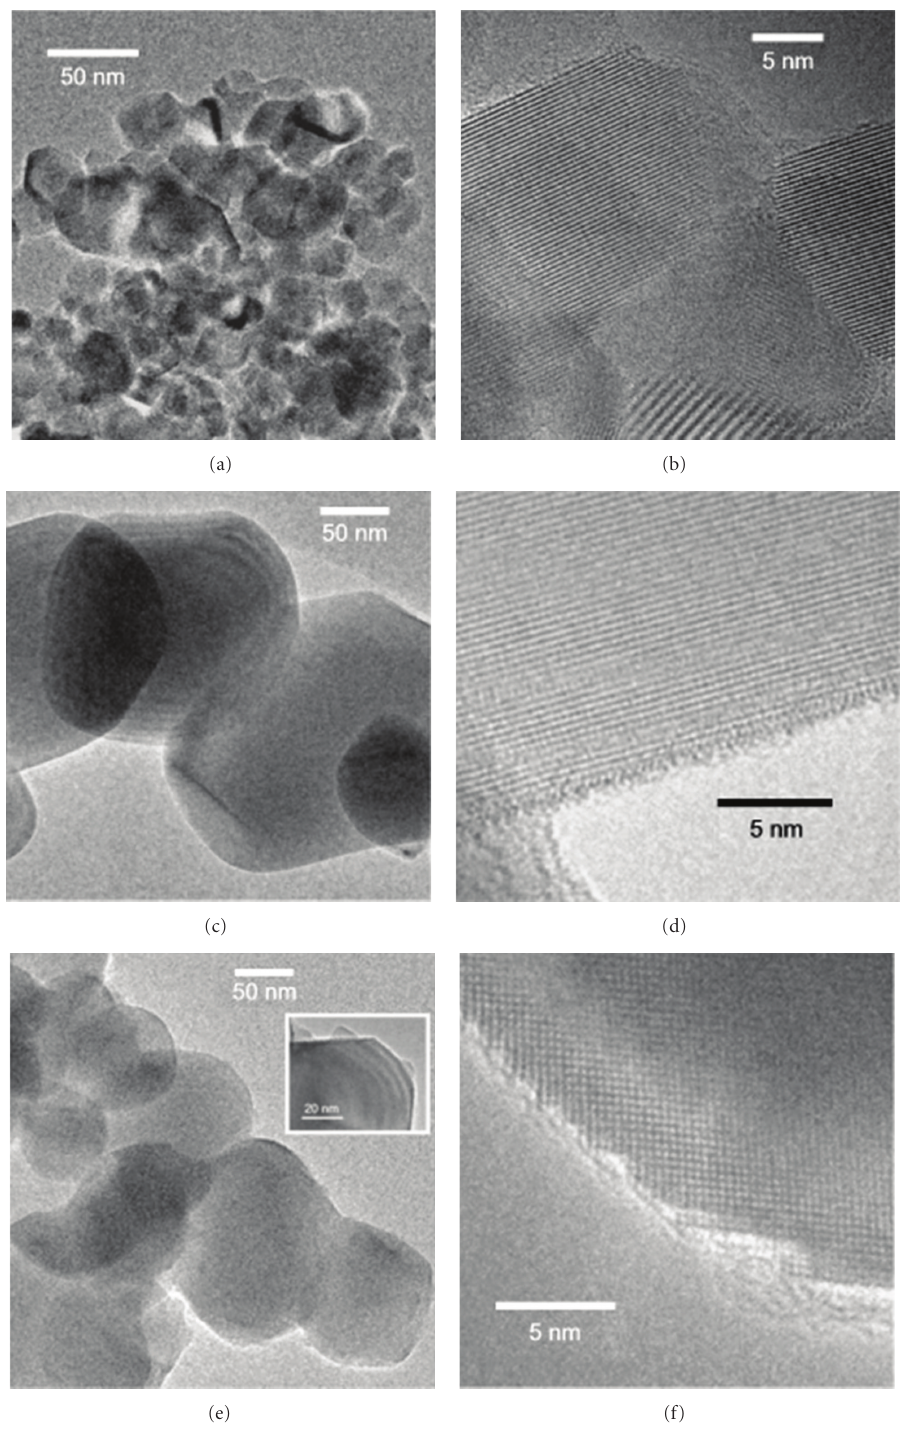
Figure 1: HR-TEM images of the various TiO 2 materials. (a) and (b): P25. (c) and (d): 1077. (e) and (f): Orosei Active. (a), (c), and (e) refer to low magnification, here as (b), (d), and (f) to high